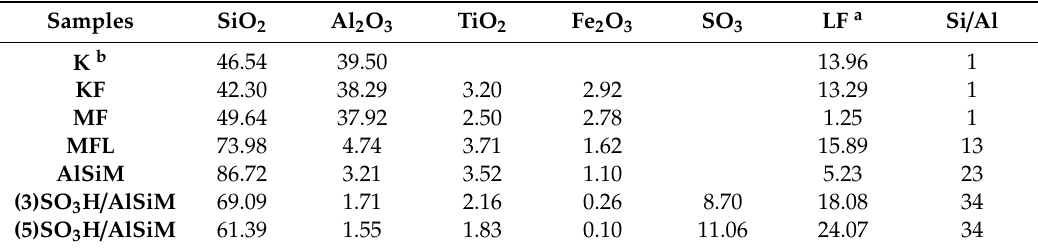
Table 1. XRF analysis results of the raw material and samples prepared.